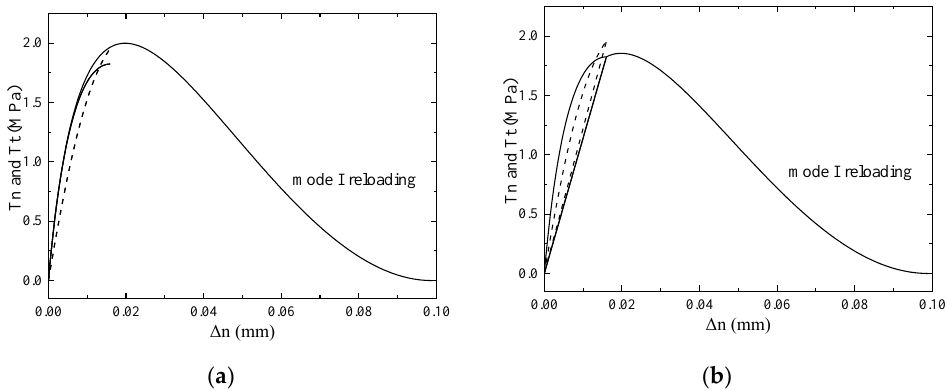
Figure 14. Variations of the traction components T n (solid lines) and T t (dashed lines) during the process of proportional loading/unloading and mode I reloading, for a proportional loading amplitude of ∆ = 0.016 mm. Model (i) and model (iii) ( a ); model (ii) ( b